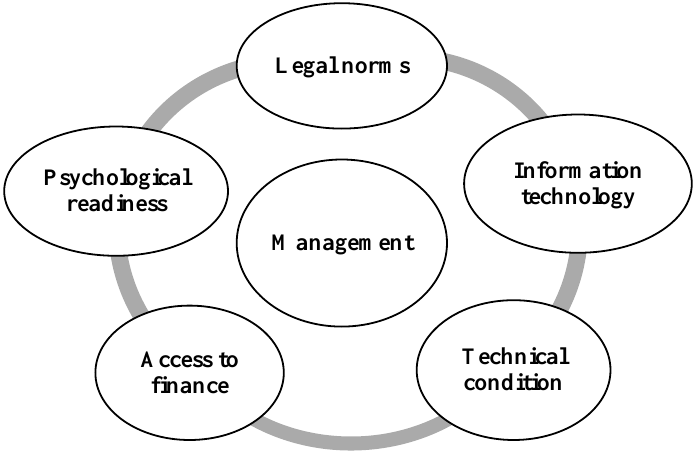
Fig. 1 . Management system elements (made by the